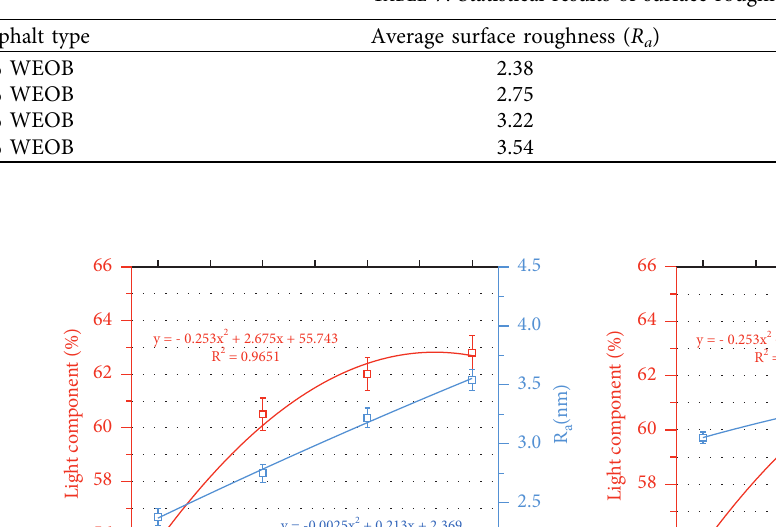
Table 7: Statistical results of surface roughness.